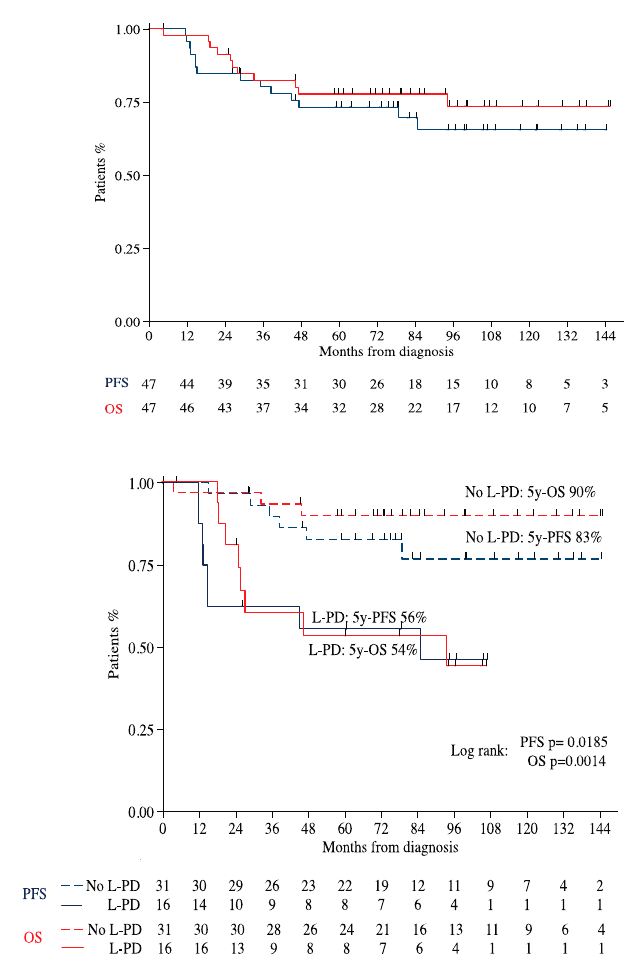
Figure 2. ( A ) Progression-free (PFS) and overall survival (OS) of the entire cohort; ( B ) PFS and OS of patients with and without local progressive disease (L-PD).